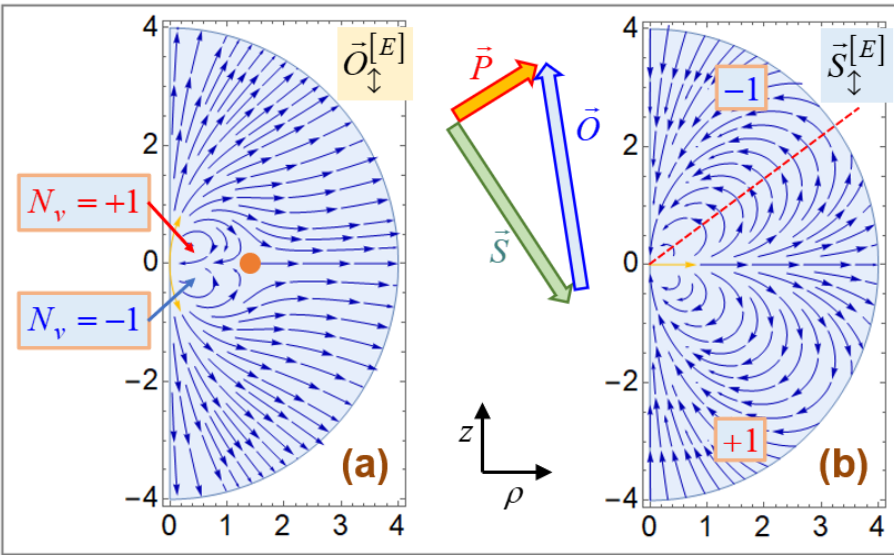
ρ -plane for a linear  [ E ] [ ] E → S S . (cid:108) 